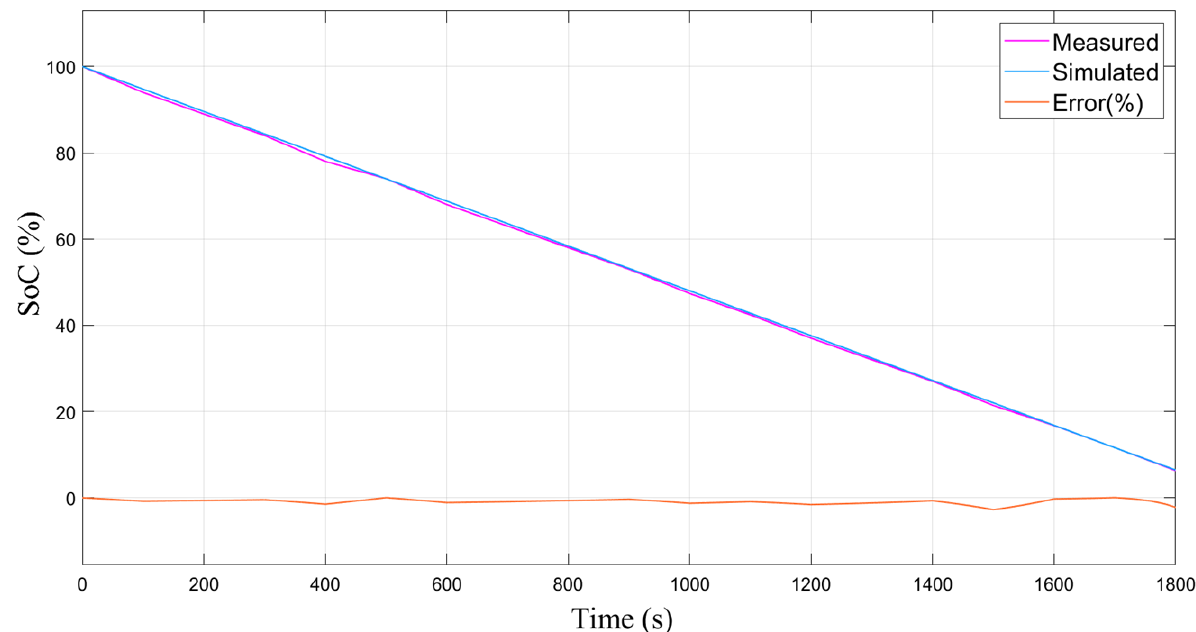
Figure 11. SoC estimation and validation result of the DP_ECM.